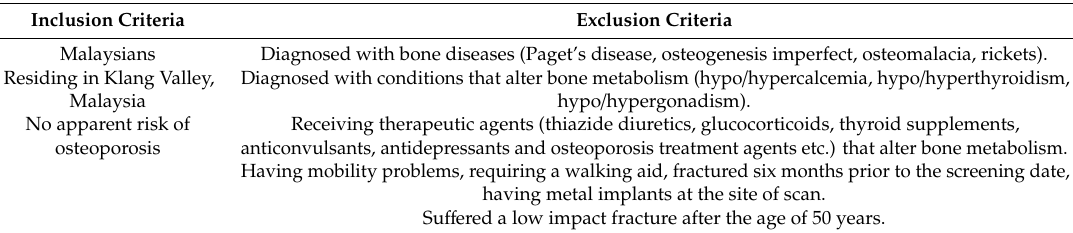
Table 1. Inclusion and exclusion criteria used in this